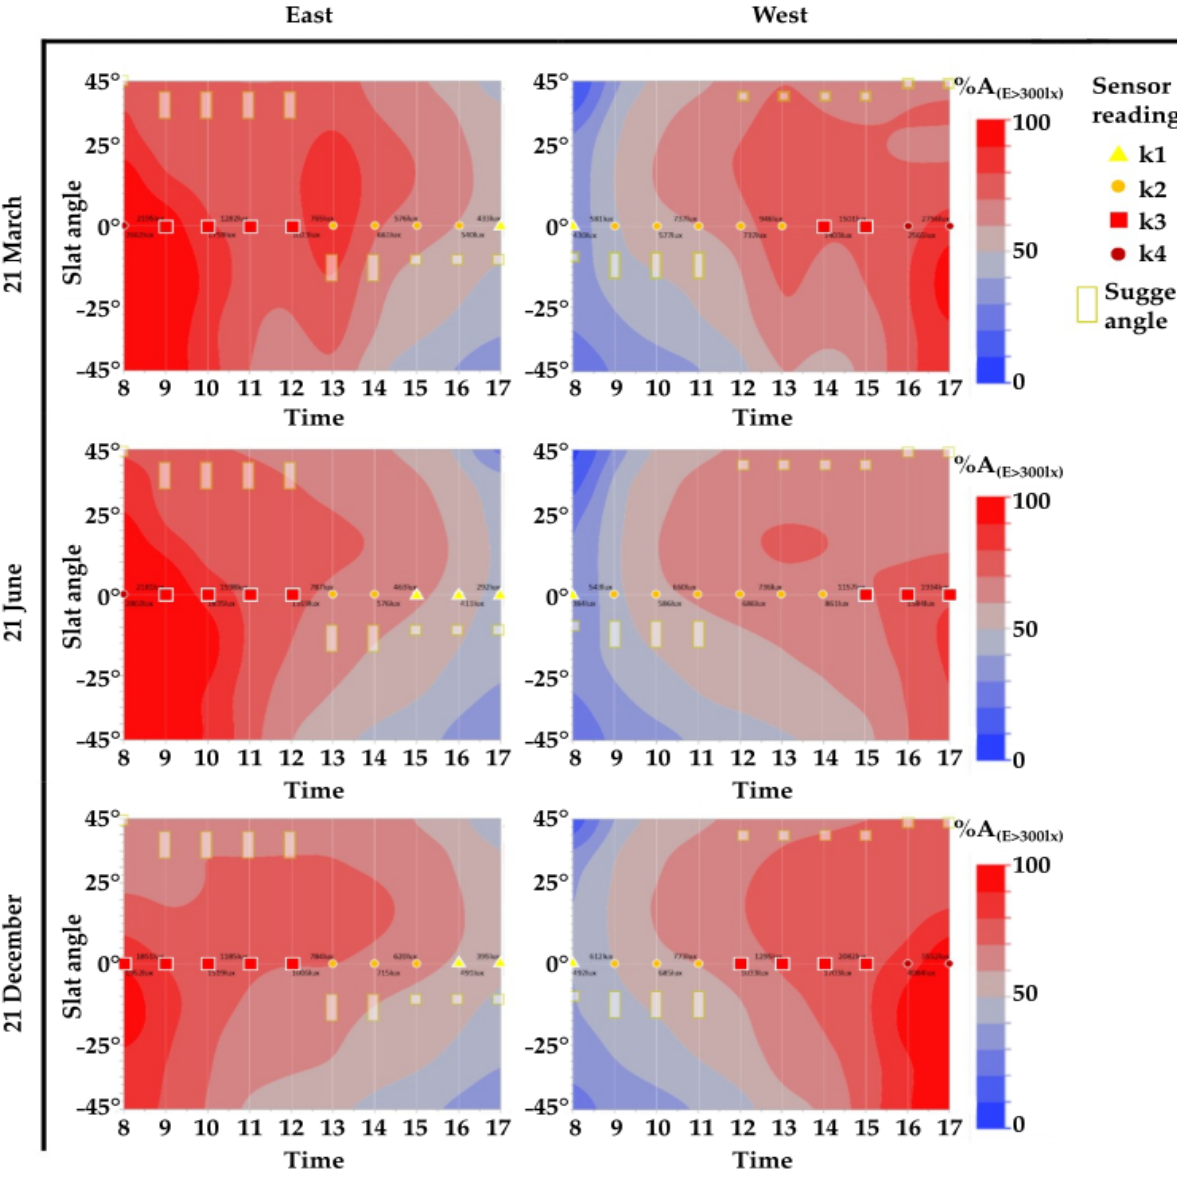
Figure 11. Relations between slat angle and time with respect to sDA 300/50% in the east and west zones on 21 March, 21 June, and 21 December.